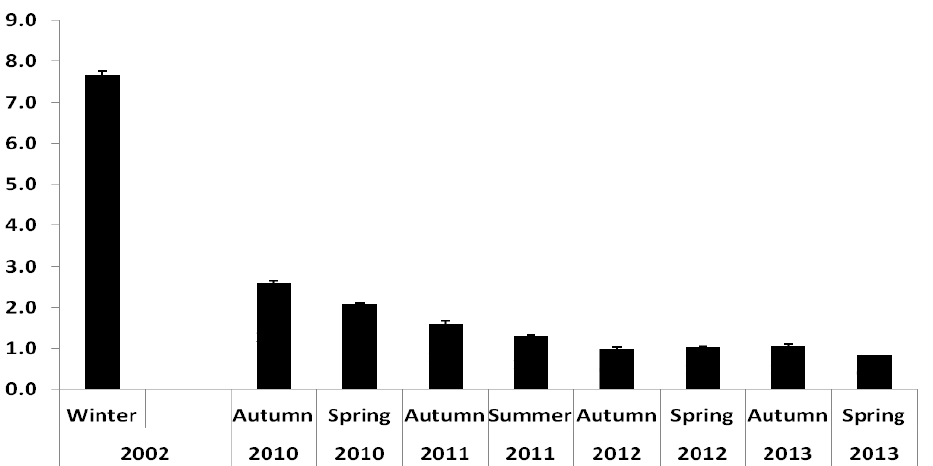
Figure 2. Ratio (±SD) of omega-3 PUFA/omega-6 PUFA in farmed Tasmanian Atlantic salmon, 2002 [10] and